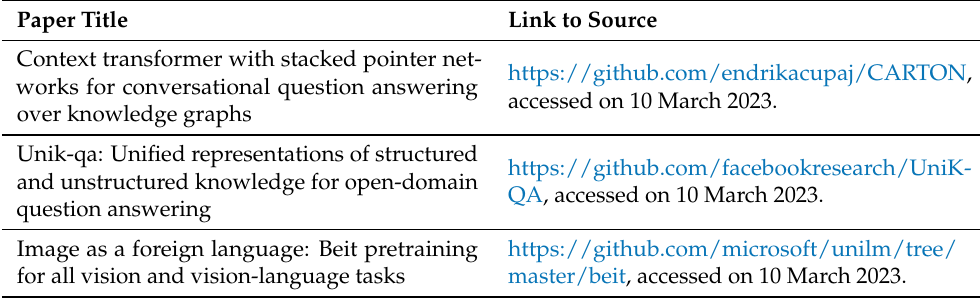
Table 12. Source code links for Multimodal Question